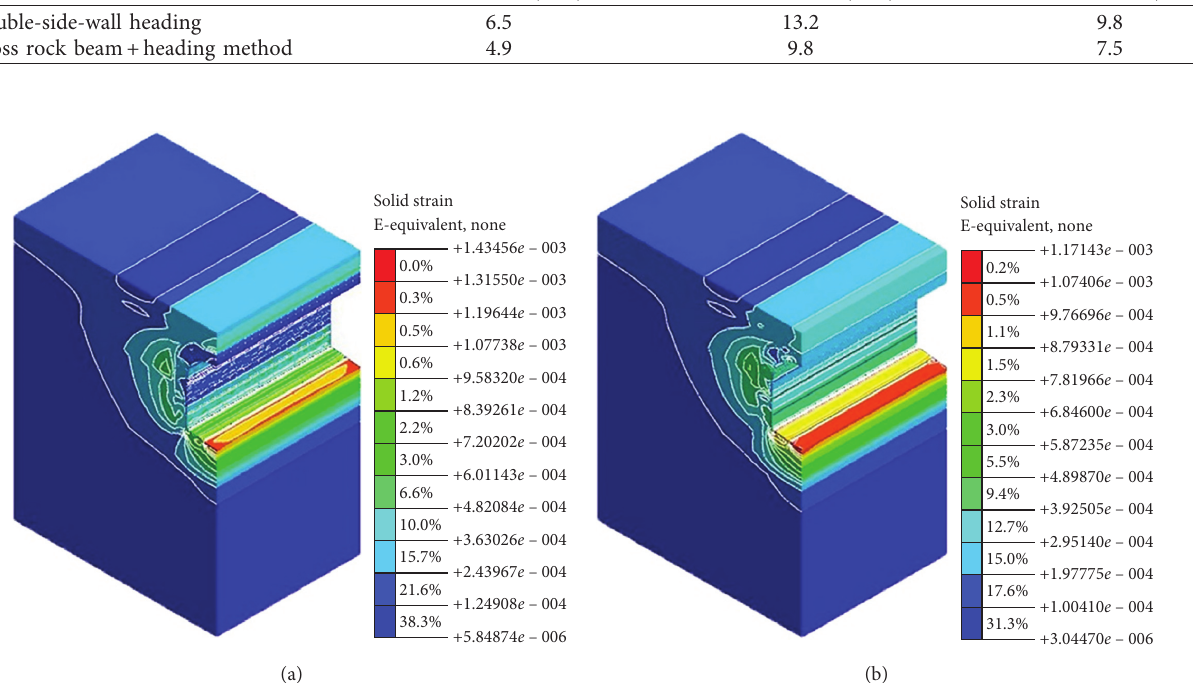
Figure 5: Equivalent plastic strain: (a) double-side-wall heading constructing method; (b) cross rock beam +heading method.